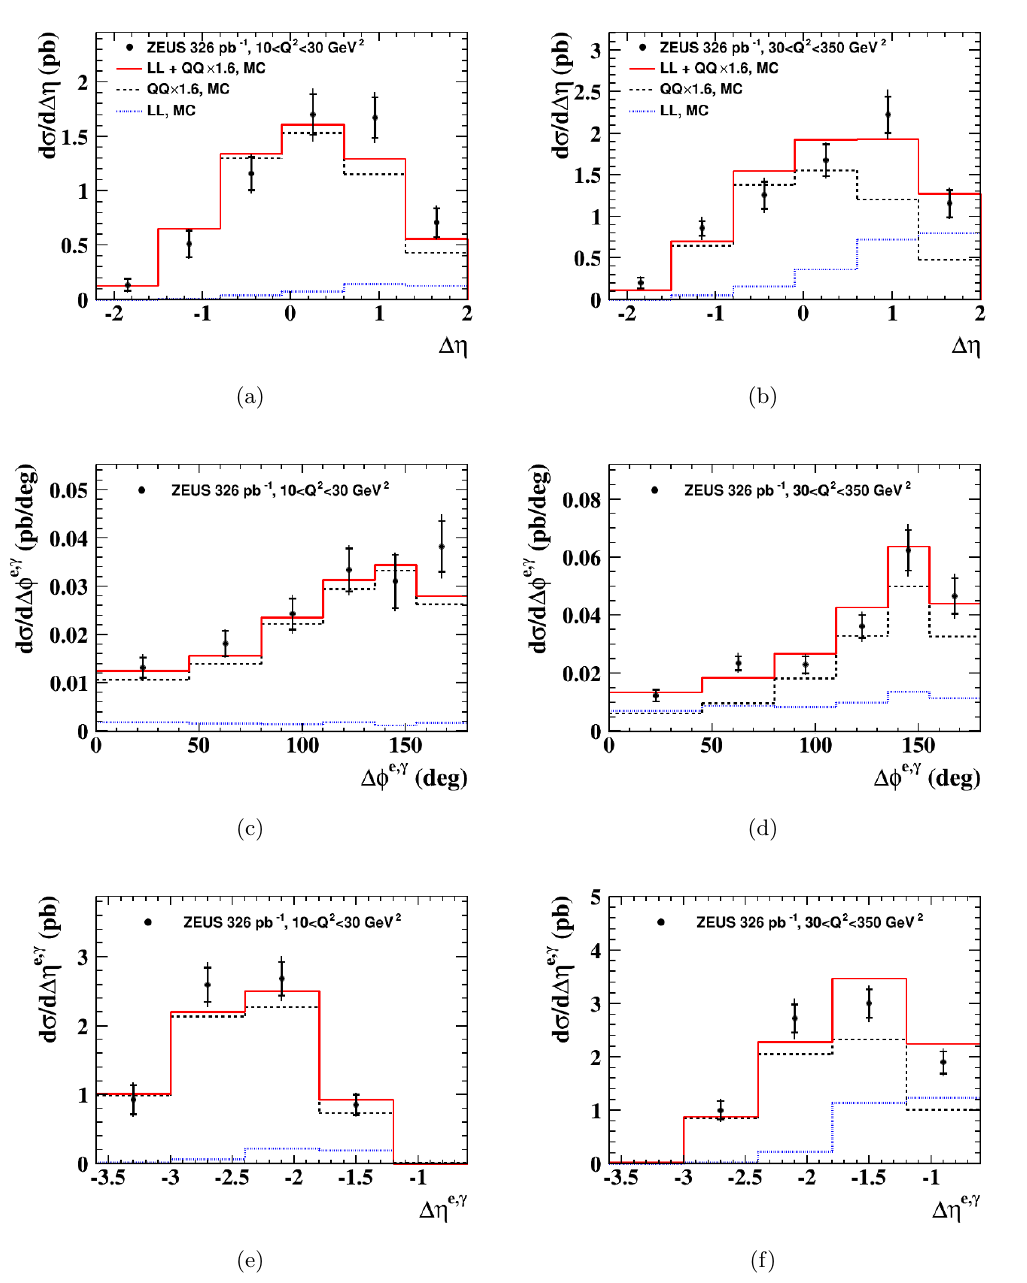
Figure 5 . Di(cid:11)erential cross sections for the regions 10 < Q 2 < 30 and 30 < Q 2 < 350 GeV 2 : (a, b) (cid:1) (cid:17) , (c, d) (cid:1) (cid:30) e;(cid:13) , and (e, f) (cid:1) (cid:17) e;(cid:13) . The inner and outer error bars show, respectively, the statistical uncertainty and the statistical and systematic uncertainties added in quadrature. The solid histograms are the Monte Carlo predictions from the sum of QQ photons from Pythia normalised by a factor 1.6 plus Djangoh-Heracles LL photons. The dashed (dotted) lines show the QQ (LL) contributions.